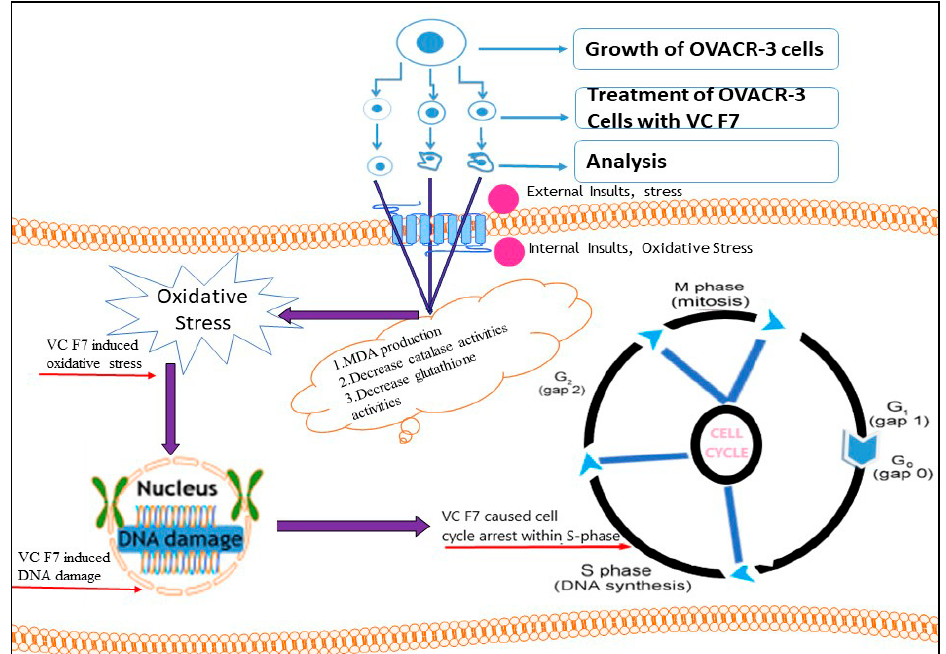
Figure 10. Underlying mechanisms by which Vernonia calvoana fraction 7 (VC F7) exerts its antitumor activity in human ovarian cancer (OVAR-3)